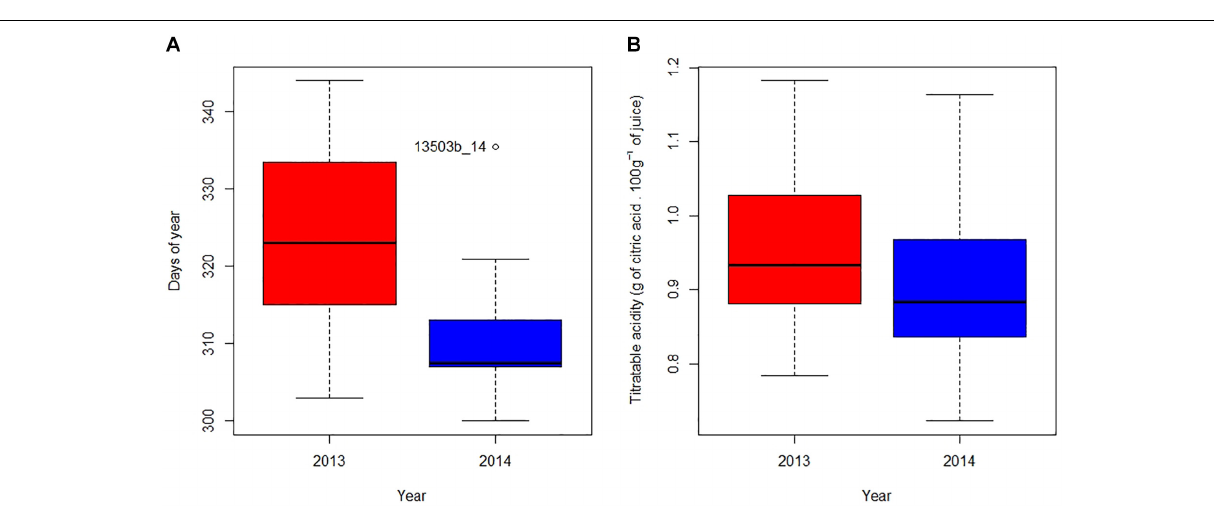
FIGURE 3 | Day of the year (A) and fruit’s acidity (B) when 20% of fruits are orange in 2013 (red) and 2014 (blue). In each boxplot, respectively from bottom to top, whiskers display the 5th and 95th percentiles, and horizontal bars indicate minimum, first quantile, median, third quantile and maximum values. Points outside the boxplot represent outliers labeled as